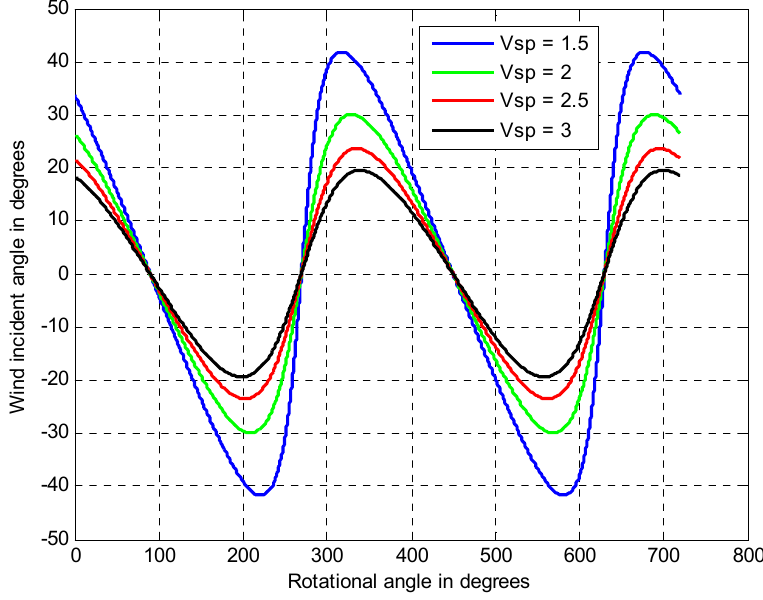
Figure 5. Angle of attack as function of the rotational